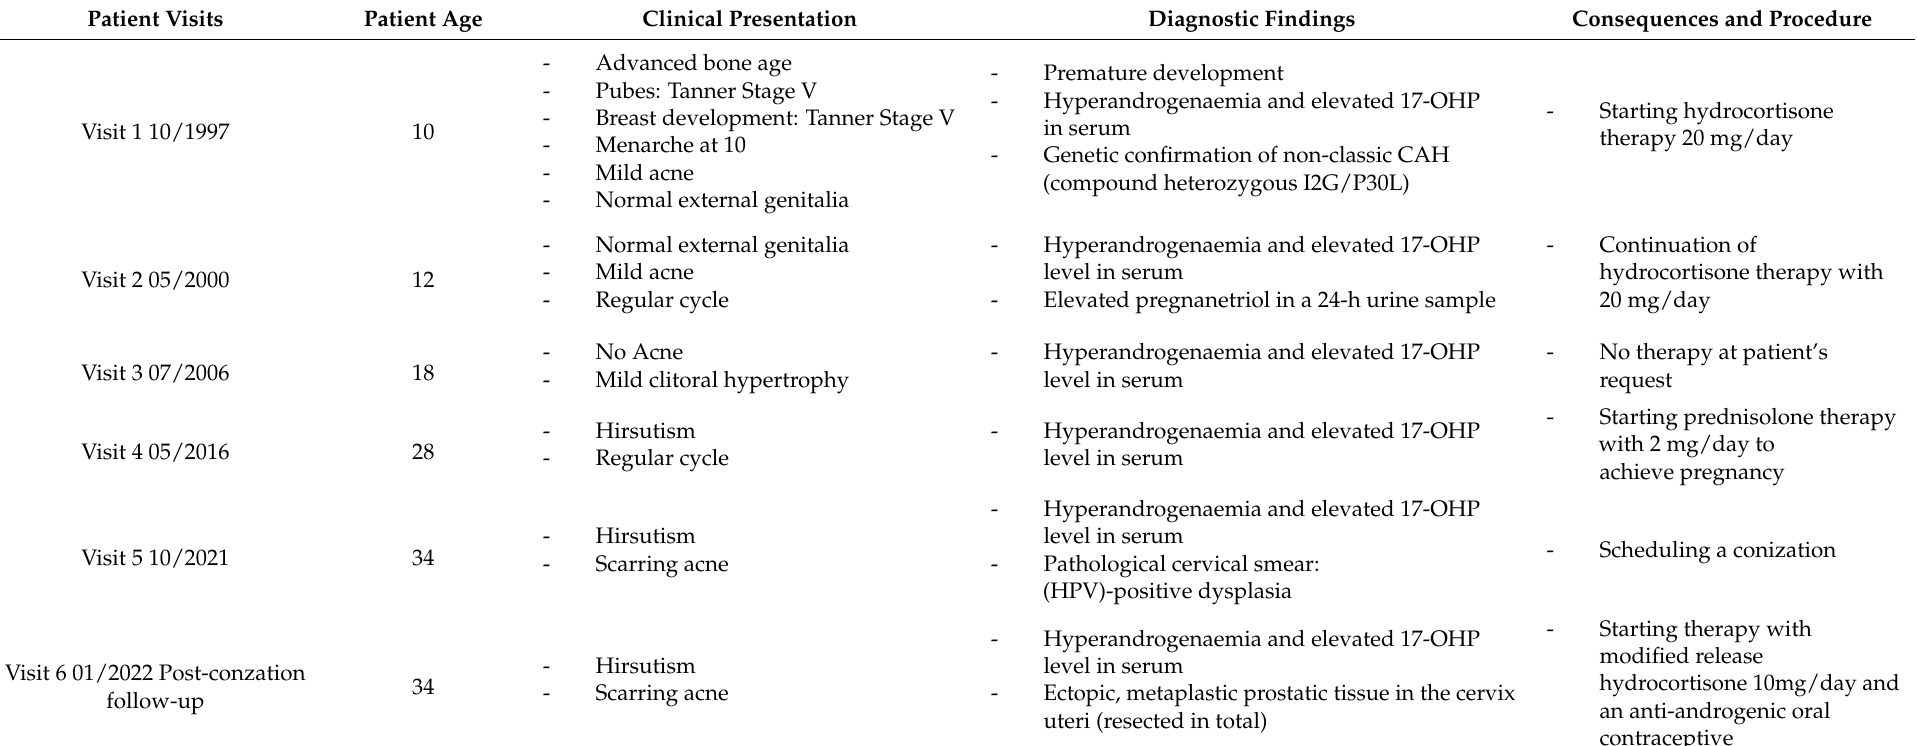
Table 1. Timeline of patient’s medical